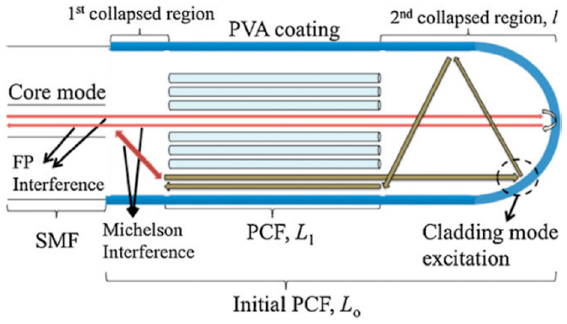
Figure 16. Schematic diagram showing the operating mechanism of the SC-PCF sensor. Reprinted with permission from [112].